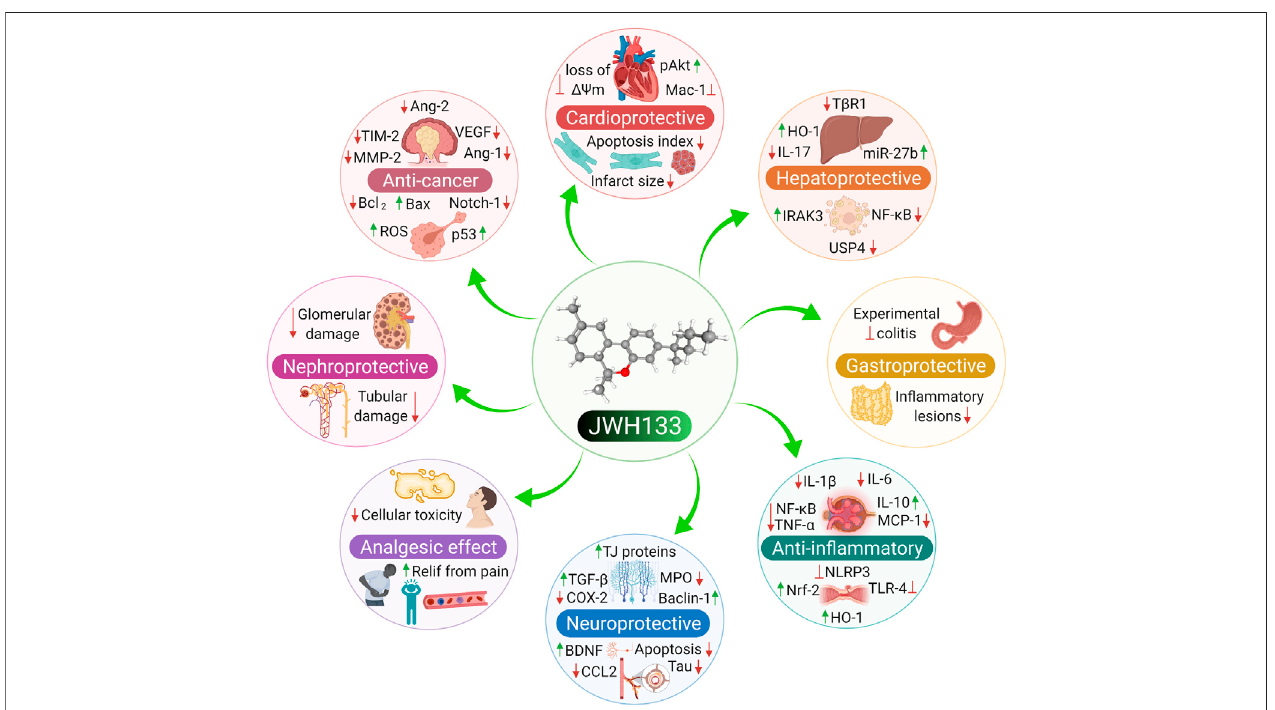
FIGURE 1 | The Pharmacological properties of